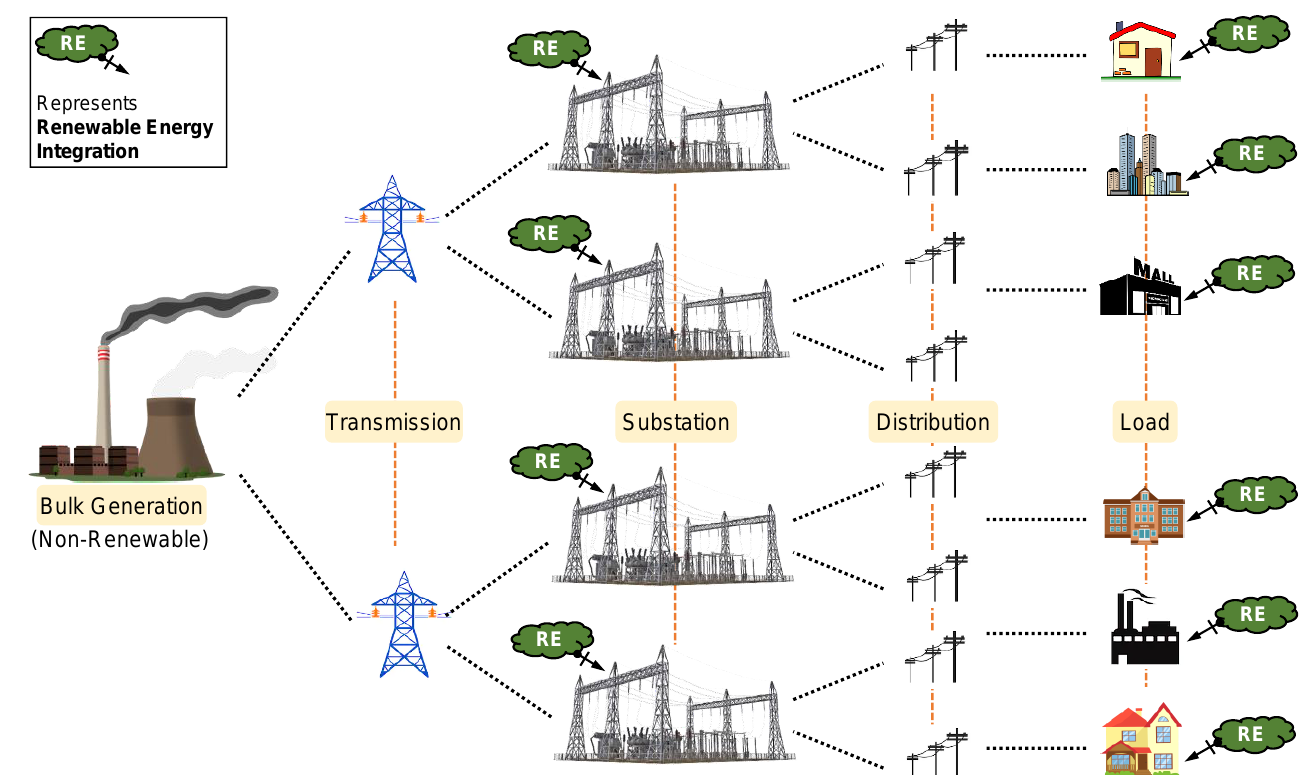
Figure 1. Renewable energy integration in the present power system scenario.